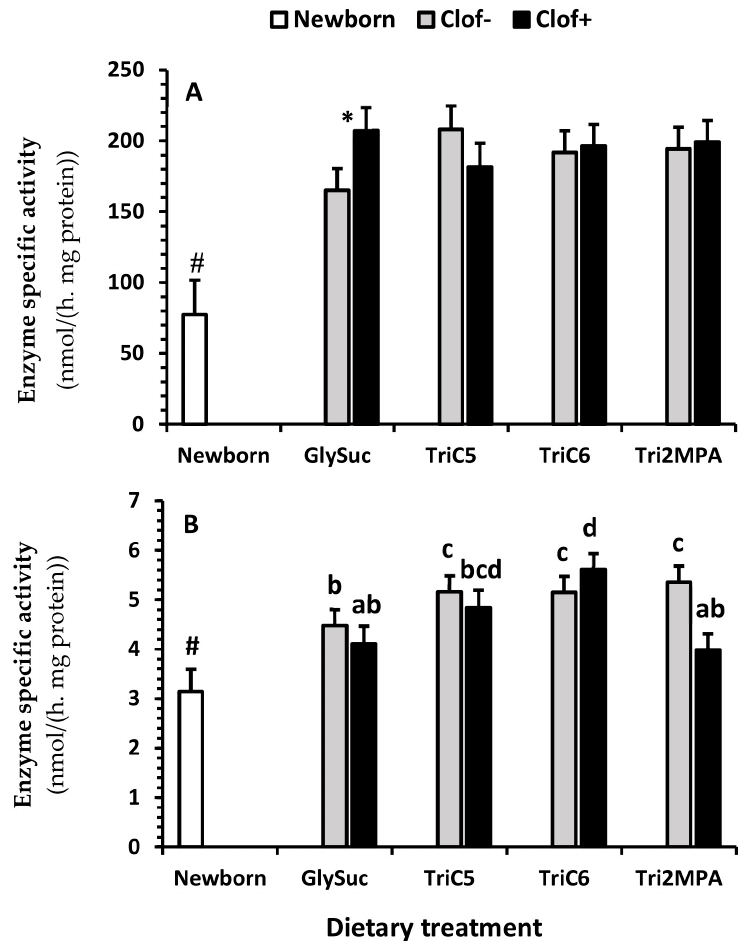
Figure 4. The e ff ect of clofibrate and dietary treatments on citrate synthase and propionyl-CoA Figure 4. The effect of clofibrate and dietary treatments on citrate synthase and propionyl-CoA carboxylase activity. Data (Lsmeans ± SEM) are specific activities (nmol / (h.mg of tissue carboxylase activity. Data (Lsmeans ± SEM) are specific activities (nmol/(h.mg of tissue protein)); n =